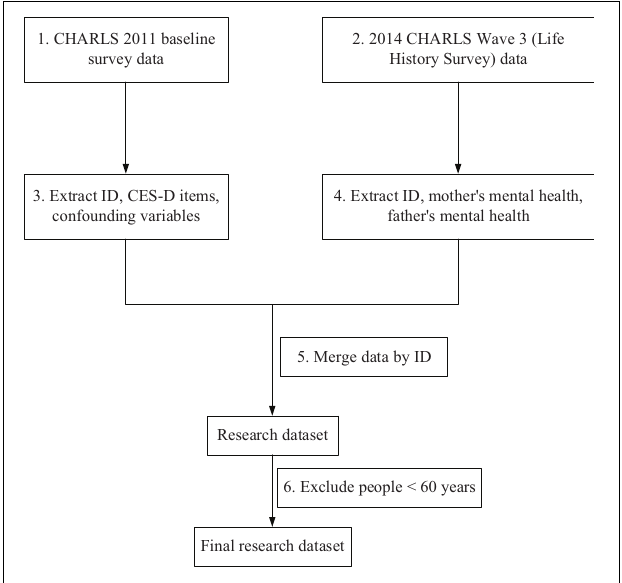
FIGURE 1 | Data processing flow